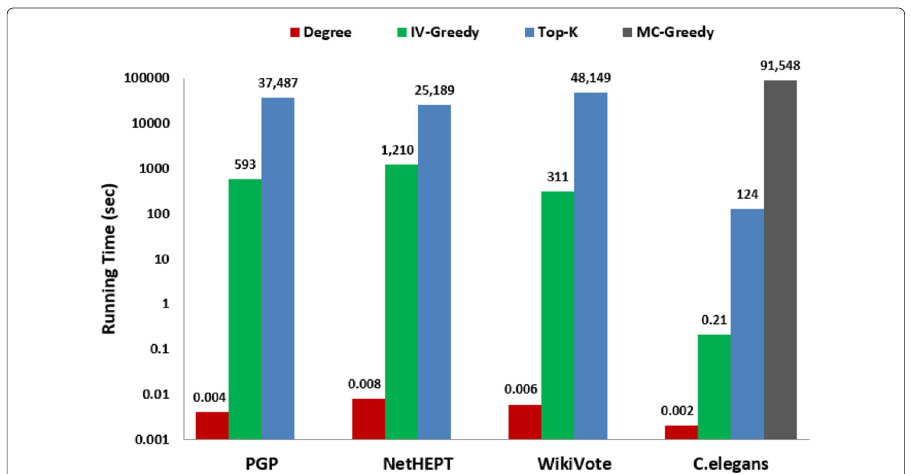
Fig. 2 Performance comparison on running time (CPU seconds)